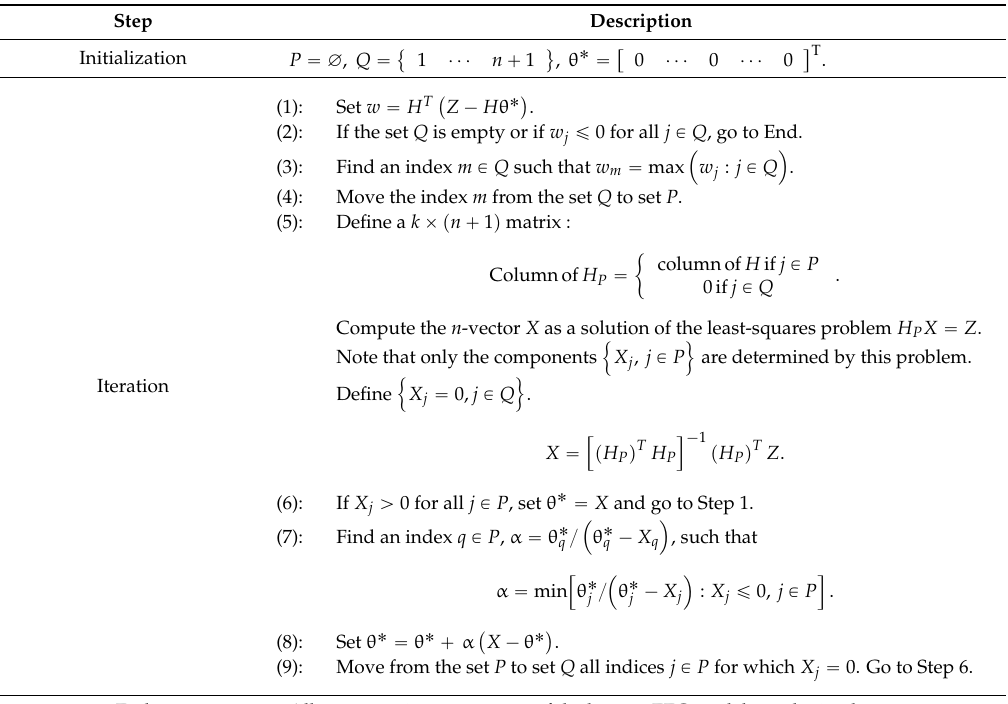
Table 2. NNLS algorithm for the parameter estimation of the EEC model of the Li-ion